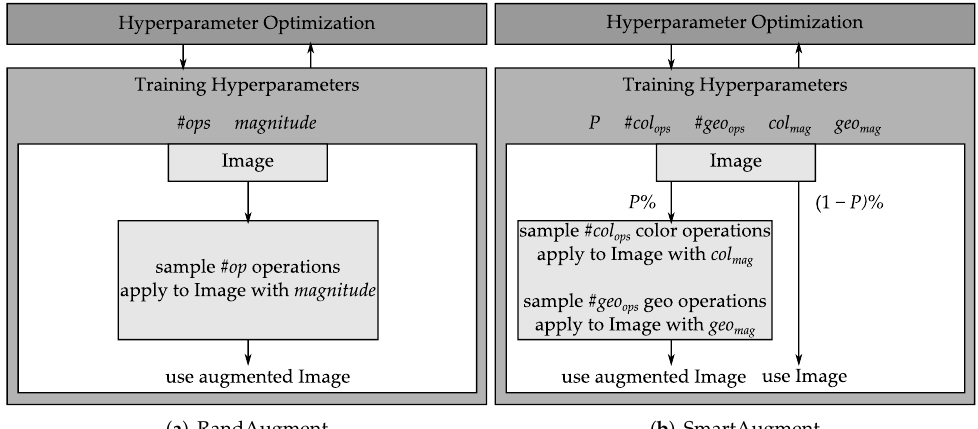
Figure 1. Comparison of RandAugment and